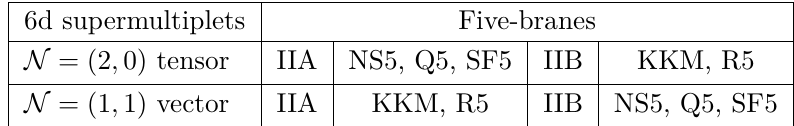
Table 1 . The five-branes in type II theories and the corresponding supermultiplets in the world- volumes. The KKM and SF5 stand for the KK-monopole and the space-filling